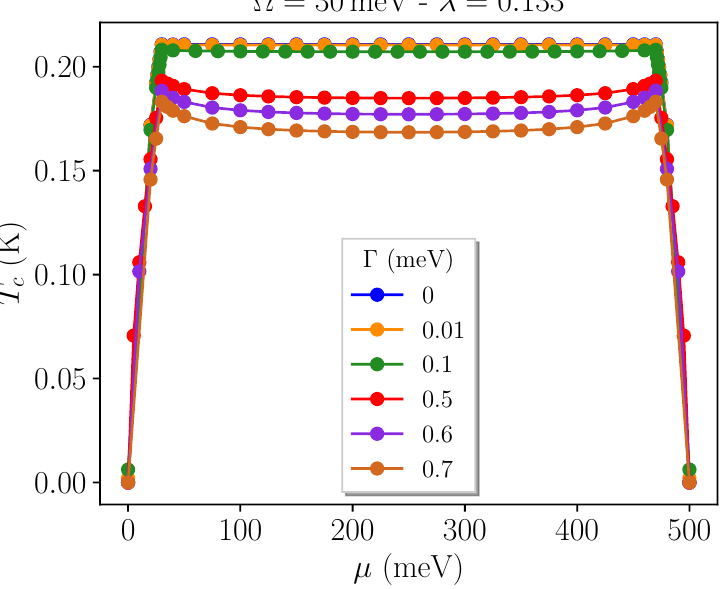
Figure 2. Critical temperature T c as a function of the chemical potential µ for a finite band, extending from w = 0 to Λ = 500 meV for different values of the disorder-induced broadening Γ ; the Debye energy is Ω = 30 meV and the coupling constant is λ =